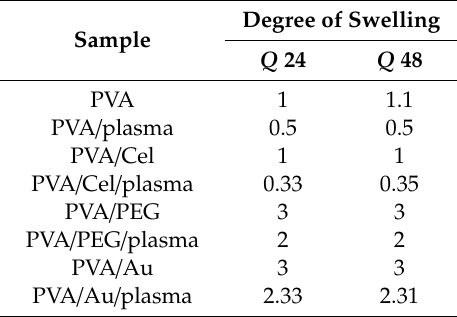
Table 3. Degree of swelling of pristine non-doped PVA foils and of PVA foils doped with cellulose (PVA / Cel), with poly(ethylene glycol) (PVA / PEG) or with Au nanoparticles in a PEG colloid solution (PVA / Au), which were either untreated or were treated with plasma, and were immersed for 24 or 48 h in